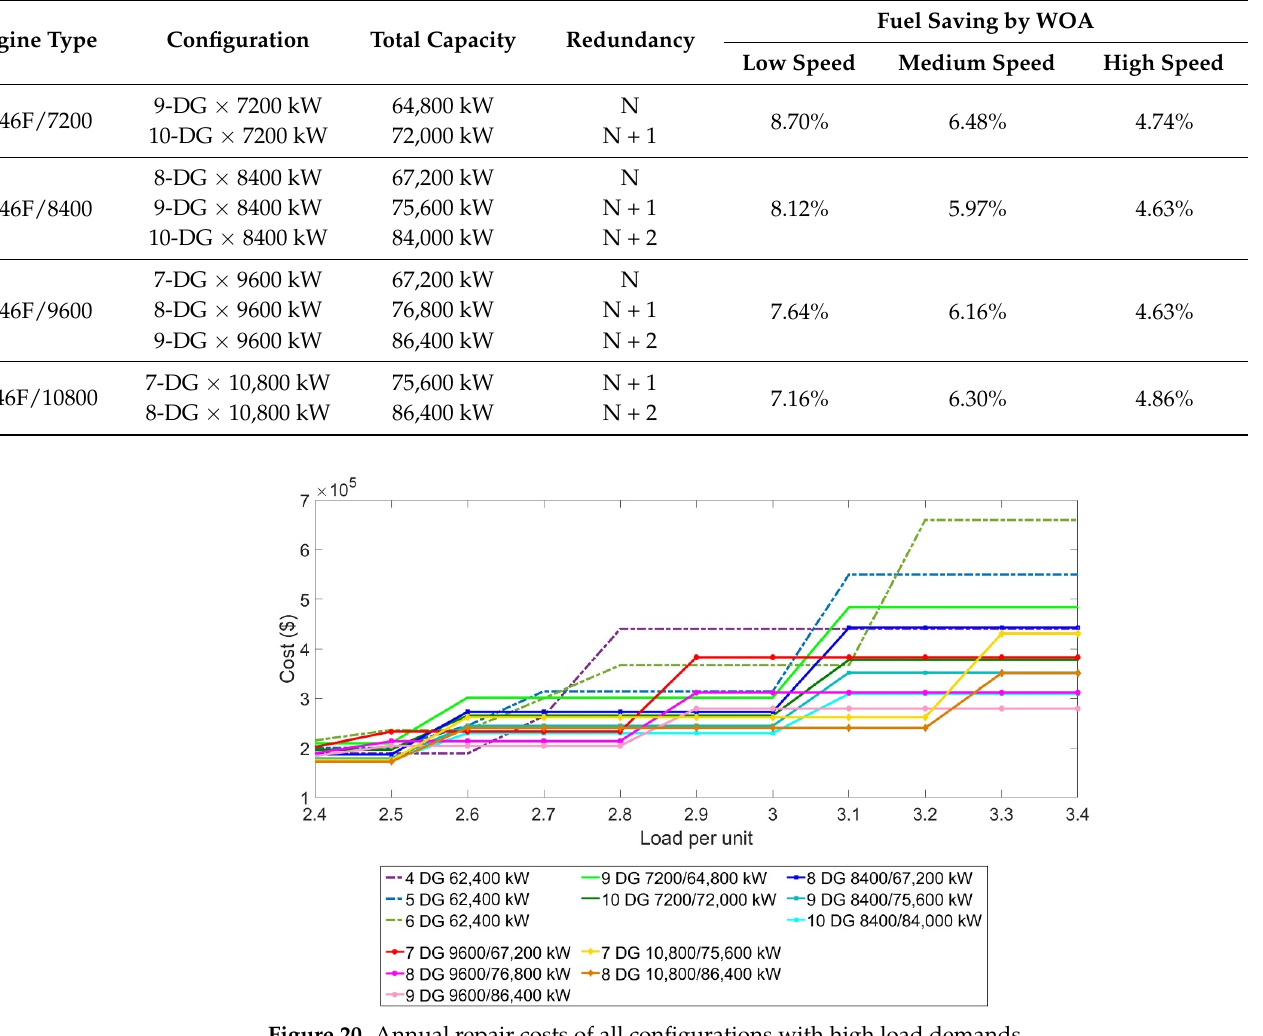
Figure 20. Annual repair costs of all configurations with high load demands.